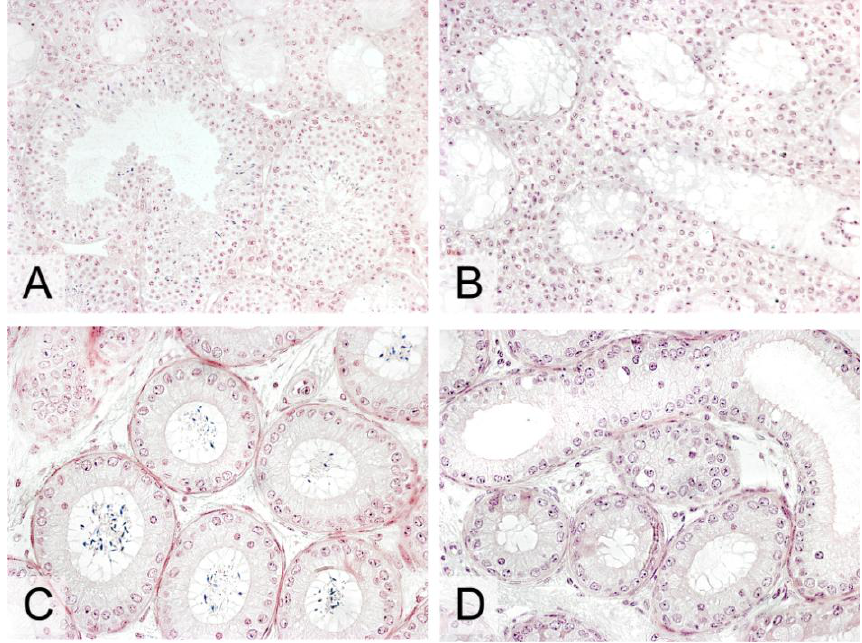
(A). The respective epididymis is also filled with sperm